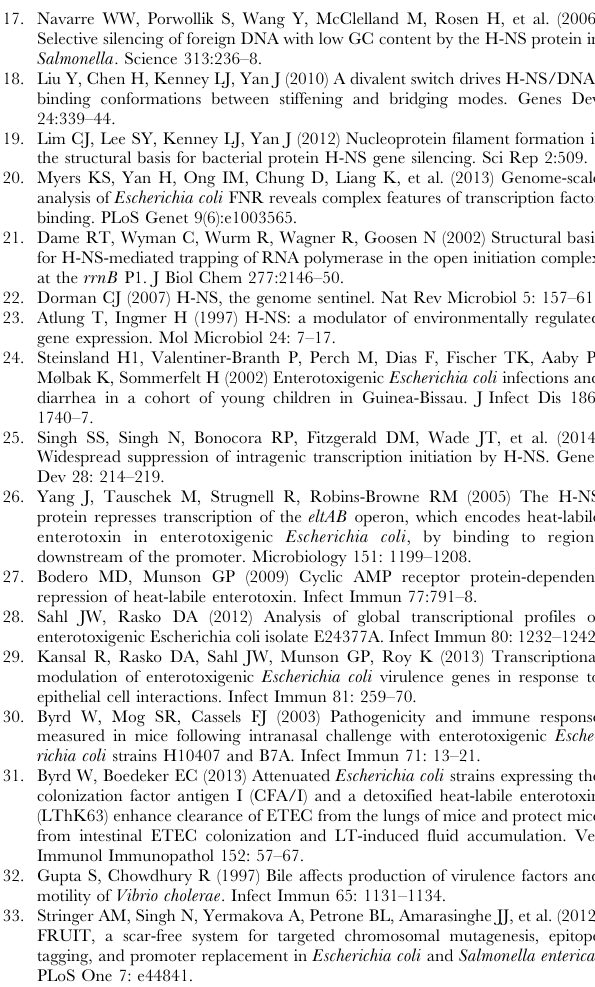
S1 Table Putative CRP binding targets on ETEC plasmids p948 and p666 identified by PREDetector. (DOCX) S2 Table Strains, plasmids and oligonucleotides. (DOCX) S3 Table All CRP binding sites on the ETEC H10407 chromosome identified by